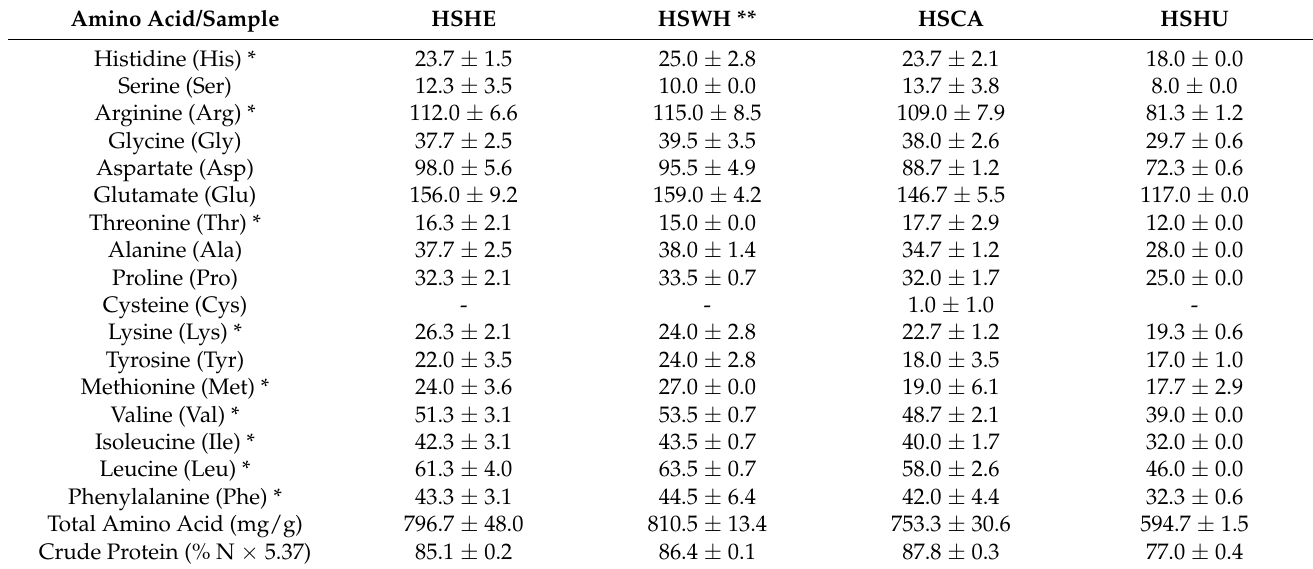
Table 2. Amino acid analysis of hemp protein isolates extracted at 0.1 M NaOH (results expressed in